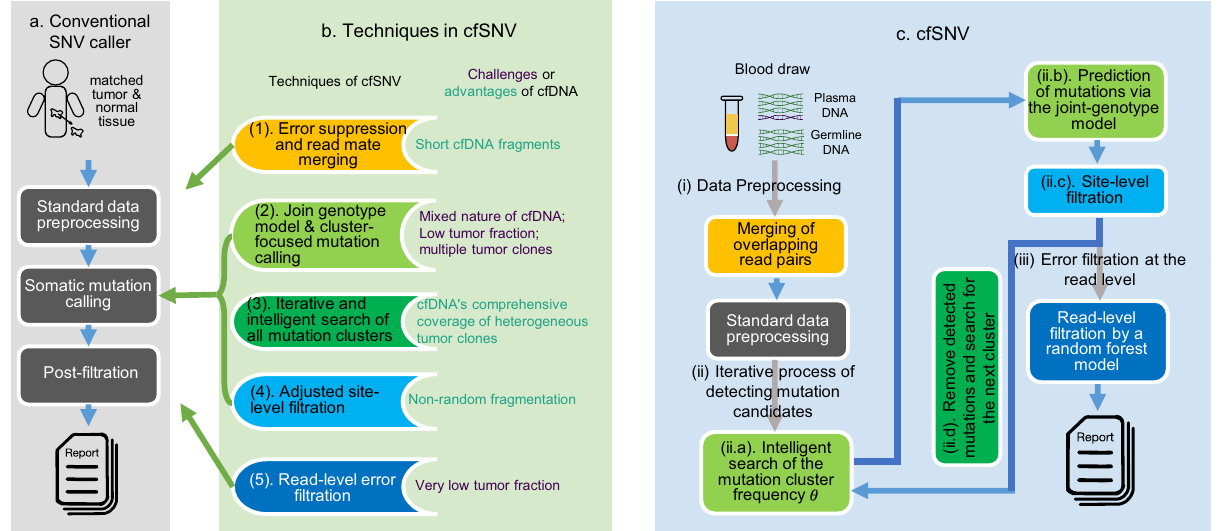
Fig. 1 cfSNV framework and its techniques. a The work fl ow of conventional SNV callers takes the genomic data of a tumor and its matched normal tissue as inputs. b Five techniques introduced in cfSNV that modify the standard work fl ow. c Full work fl ow of cfSNV. cfSNV takes plasma DNA and germline DNA sequencing data as inputs. No tumor samples are needed. It fi rst merges overlapping read pairs in cfDNA sequencing data. Next, we apply standard data